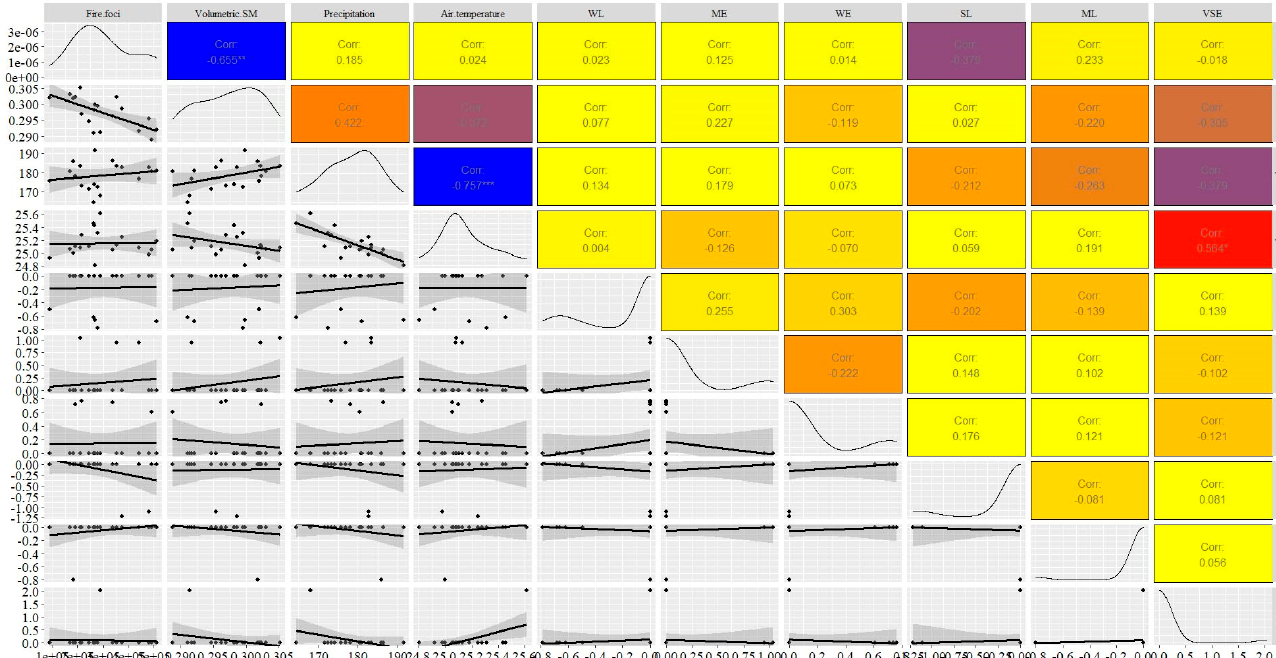
Figure 11. Correlation matrix for climate variables. Legend: fire foci, VSM, precipitation, air temperature, “Weak” La Niña (WL), “Moderate” La Niña (ML), “Strong” La Niña (SL), “Weak” El Niño (WE), “Moderate” El Niño (ME), “Strong” El Niño (SE), and “Very Strong” El Niño (VSE) for all years in the period 2001–2019 with the ENOS classification.